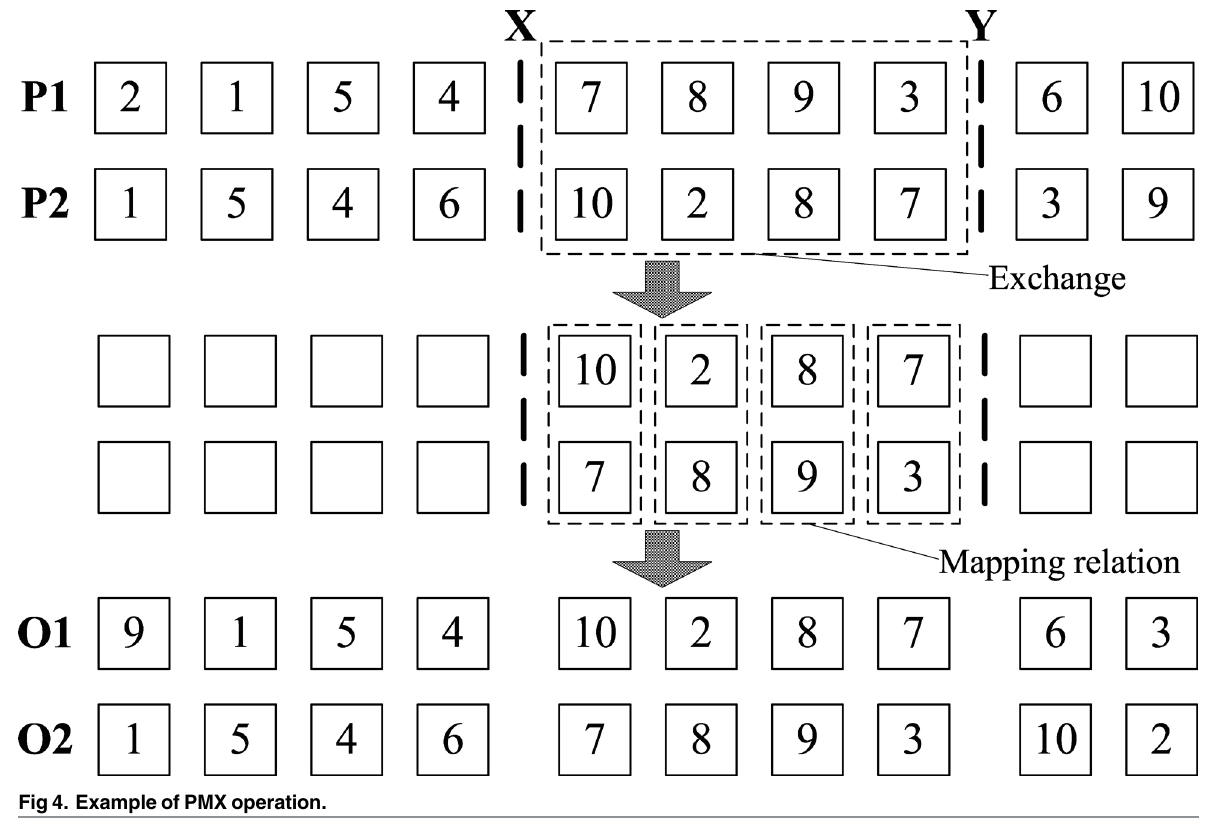
Fig 4. Example of PMX